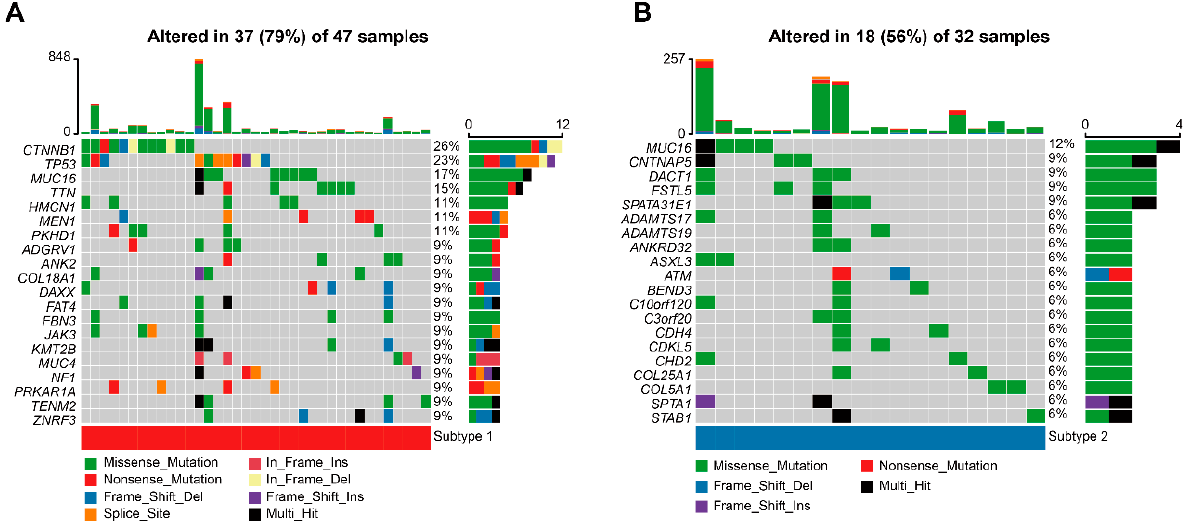
Figure 8. Somatic variants and TME-related subtypes. ( A ) Waterfall plot visualizing the top 20 highly mutated genes of subtype 1. ( B ) Waterfall plot visualizing the top 20 highly mutated genes of subtype 2.